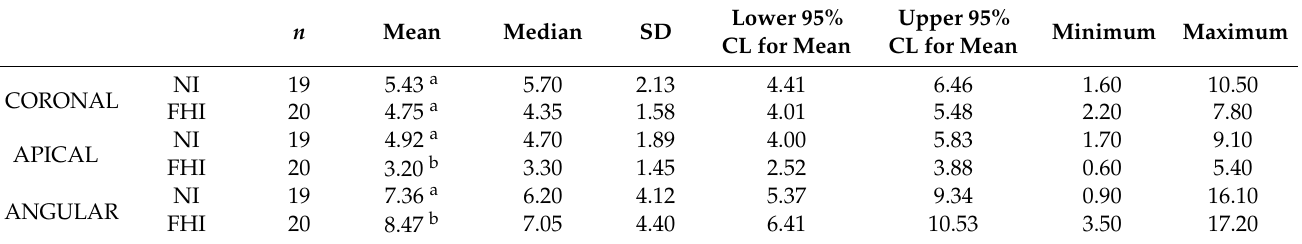
Table 1. Descriptive values of deviations at the coronal entry point (mm), apical end point (mm), and angular (°) deviations of the computer-aided dynamic navigation technique (NI) and the free- hand approach.